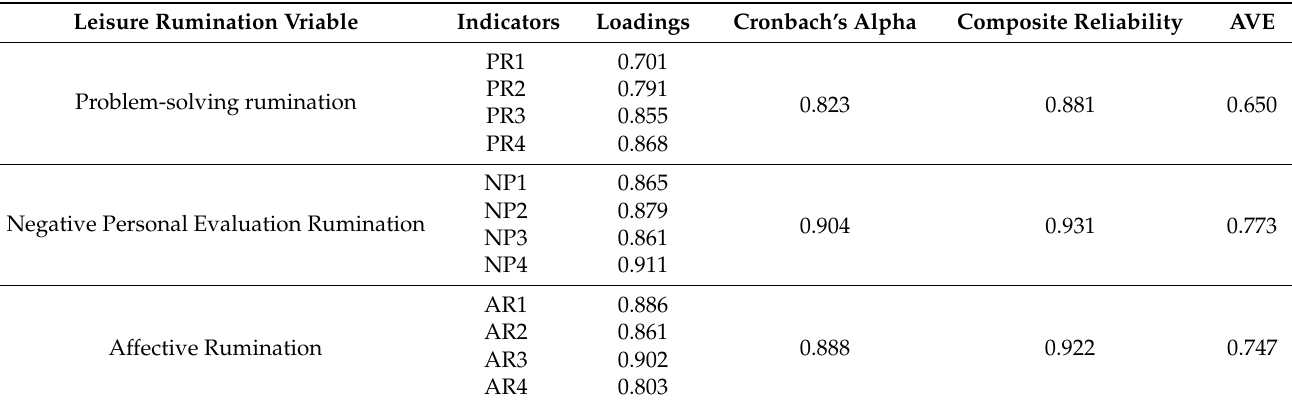
Table 1. Validity of the Leisure Rumination